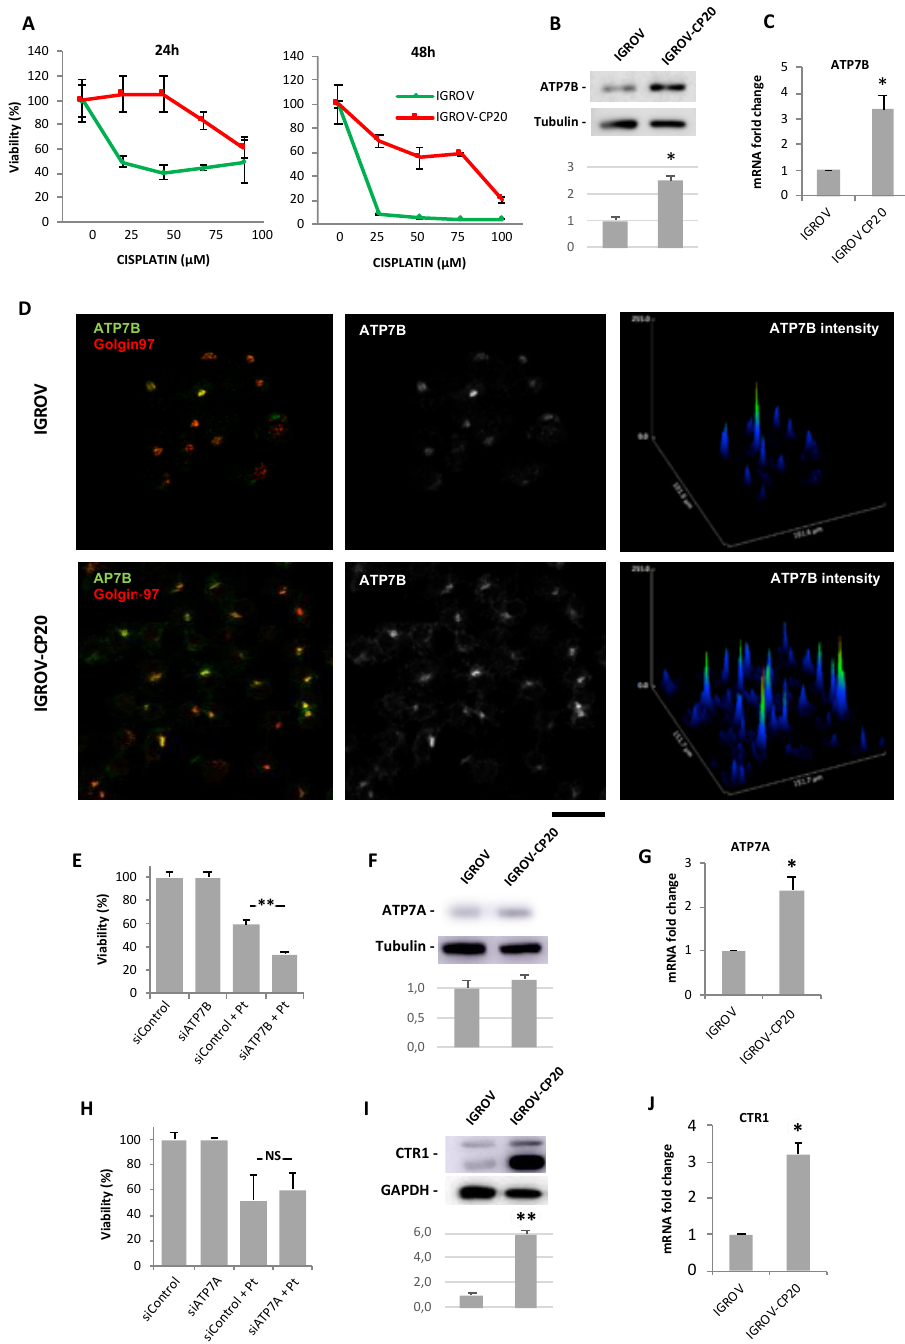
Figure 1. Cisplatin resistance of IGROV-CP20 cells requires ATP7B. ( A ) IGROV (green) and IGROV-CP20 (red) cells were treated with the indicated concentrations of cisplatin for 24 or 48 h and viability of the cells was then evaluated using the MTT assay. ( B , F , I ) Western blots (and corresponding density quantifications) show ATP7B (B), ATP7A (F), and CTR1 (I) protein levels in IGROV and IGROV-CP20 cells ( n = 3 experiments; * p < 0.05, ** p < 0.01, t -test). ( C , G , J ) qRT-PCR shows ATP7B (C), ATP7A (G), and CTR1 (J) mRNA levels in IGROV and IGROV-CP20 cells ( n = 3 experiments; * p < 0.05, t -test). ( D ) IGROV and IGROV-CP20 cells were labeled for ATP7B and Golgin-97. Graphs (right column) indicate